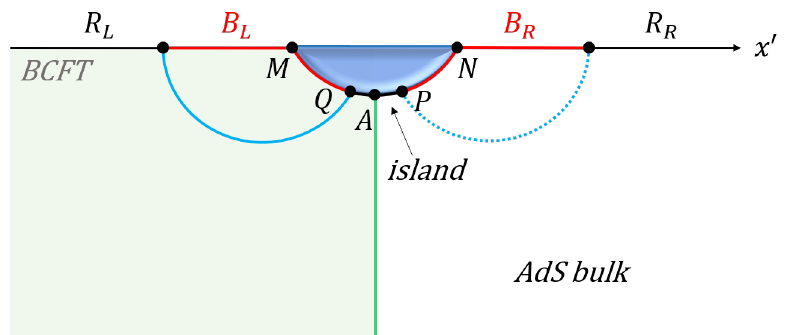
Figure 17. The disconnected phase viewed along z -axis. A black hole time slice has two separated regions B L and B R , which are separated by an island on the EOW brane. It is obvious that the island (black curve QP ) belongs to the entanglement wedge of radiation. The island is divided into left and right parts, which are denoted by I L (black curve QA ) and I R (black curve PA ) respectively. The entanglement wedge of the left system R L ∪ B L is again represented by the green shaded